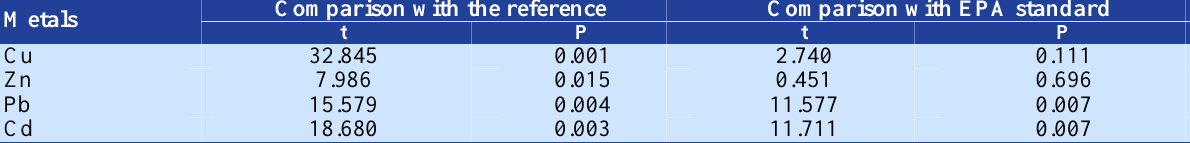
Table 4. One sample t-test results for the comparison of the heavy metals in the soil of the contaminated site with those of the uncontaminated (reference) site and Environmental Protection Agency (EPA) standard